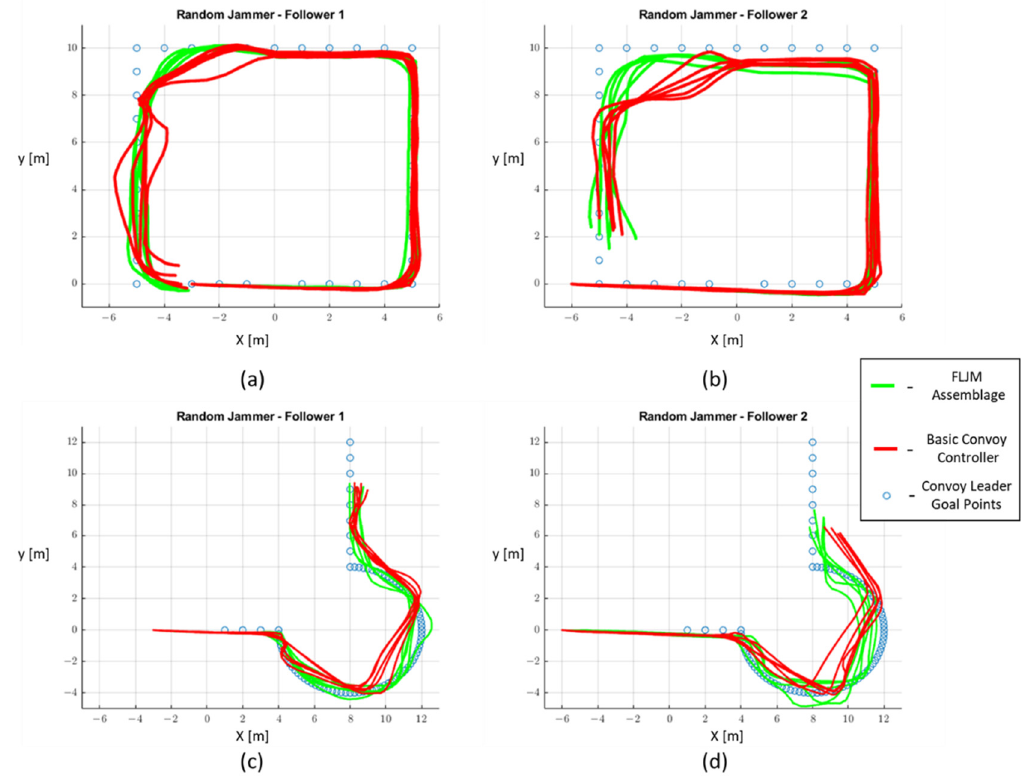
Figure 18. Plot of the paths taken by the followers under random jamming on the square path for ( a ) follower 1 and ( b ) follower 2; and on the roundabout path for ( c ) follower 1 and ( d ) follower 2.